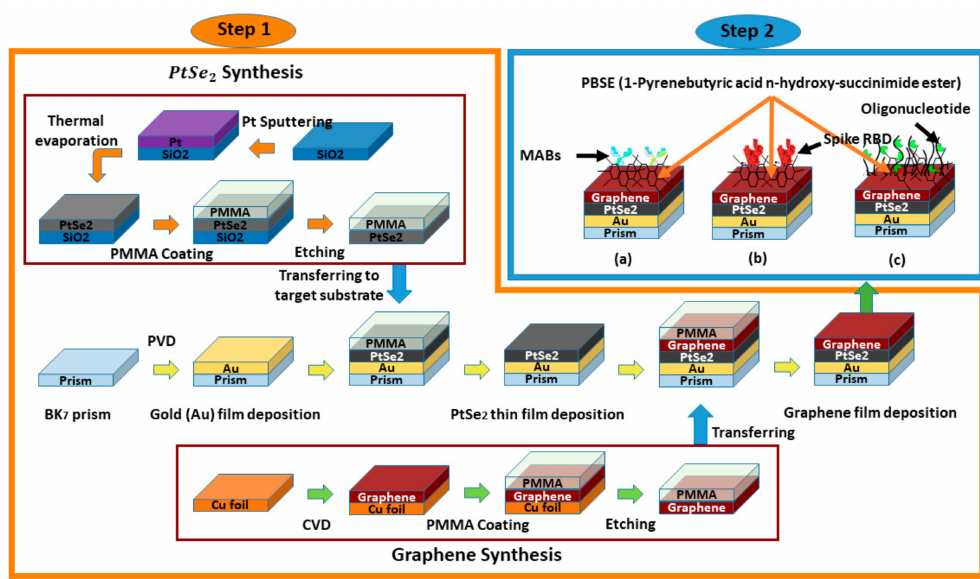
Figure 3. Schematic diagram of the possible multi-layer film fabrication process of the proposed SPR sensor for detection of the SARS-Cov-2 virus;—in step 1, the sensor Bk 7 /Au/PtSe 2 /graphene layers are deposited sequentially, the synthesis technique of PtSe 2 and graphene film are also depicted. In step 2, the ligands;—( a ) mAbs, ( b ) spike RBD, and ( c ) probe oligo are immobilized with the graphene layer through